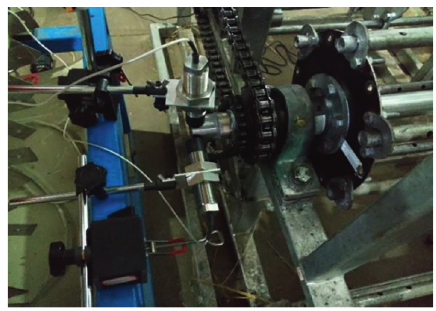
Figure 9: Eddy current sensor installation method.